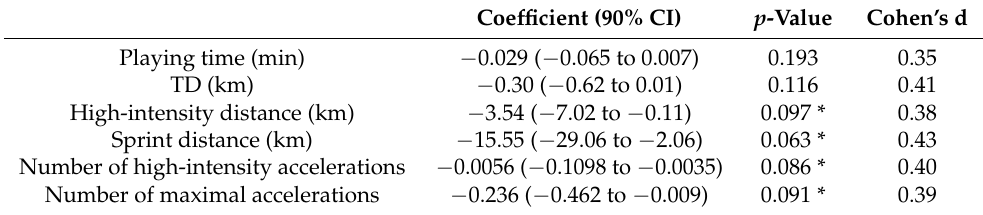
Table 3. Effects of playing time and physical performance on s-Cort differences calculated between 30-min post-match and 60-min before kick-off time points. Coefficient (90% CI) p -Value Cohen’s d Playing time (min) 0.005 ( − 0.042 to 0.053) 0.838 0.06 TD (km) 0.01 ( − 0.41 to 0.42) 0.999 0.00 High-intensity distance (km) 0.31 ( − 4.24 to 4.83) 0.910 0.03 Sprint distance (km) 1.09 ( − 17.42 to 18.78) 0.921 0.02 Number of high-intensity accelerations − 0.011 ( − 0.081 to 0.059) 0.778 0.07 Number of maximal accelerations 0.073 ( − 0.243 to 0.371) 0.686 0.09